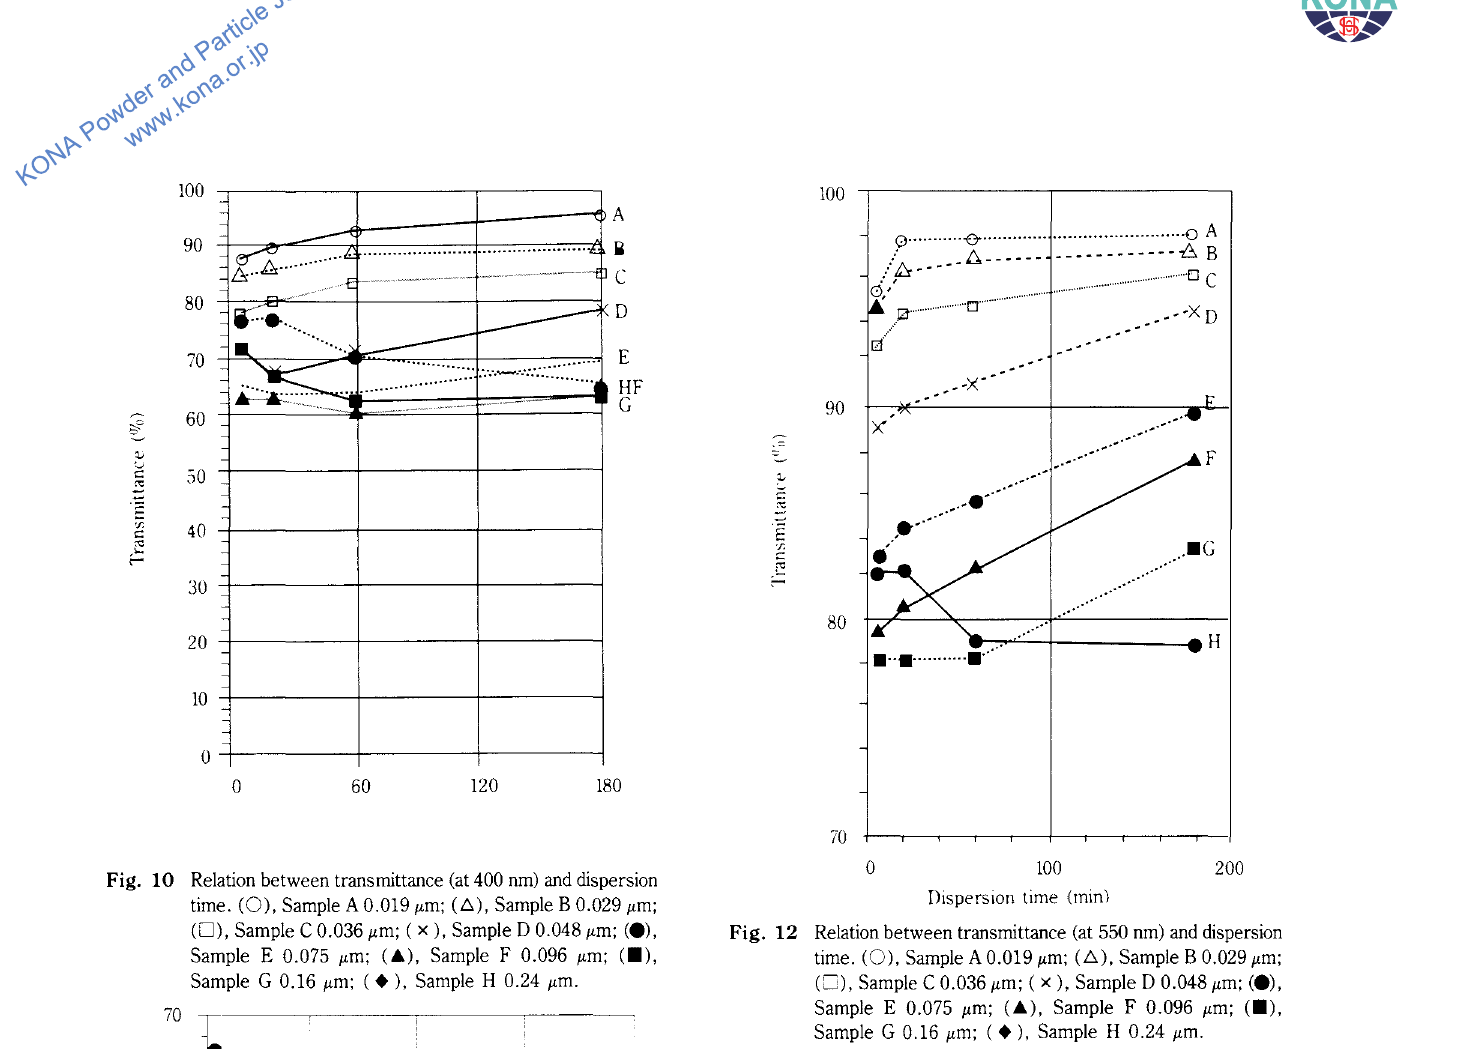
Fig. 12 Relation between transmittance (at 550 nm) and dispersion time. (0), Sample A 0.019/lm; (6), Sample B 0.029/lm; (:::=),Sample C 0.036/lm; ( x ), SampleD 0.048/lm; (e), Sample E 0.075 I'm; (A), Sample F 0.096 I'm; (•). Sample G 0.16 I'm; ( + ), Sample H 0.24